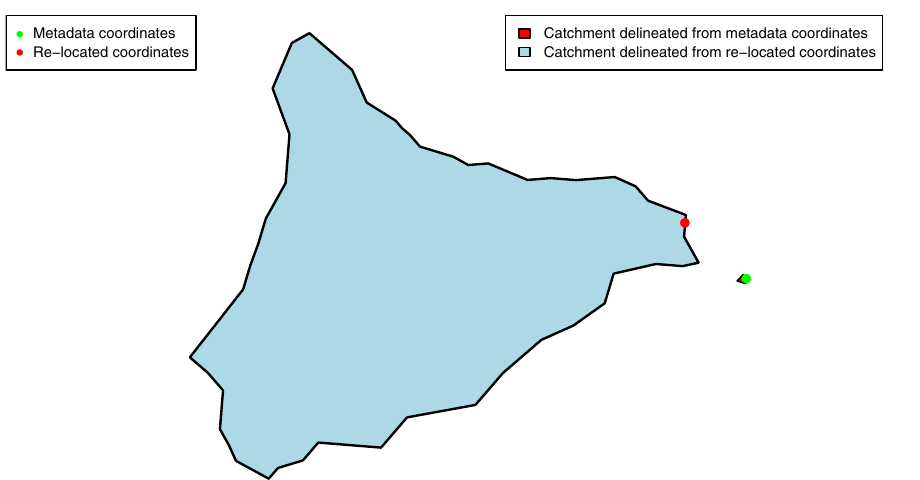
Figure 4. Example of improvement in quality of a catchment boundary using re-located geographical coordinates (for station